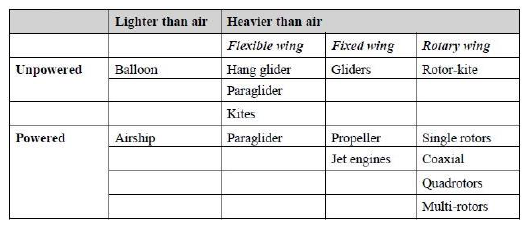
Table 1. Classification of UAVs by Eisenbeiss (Eisenbeiß,